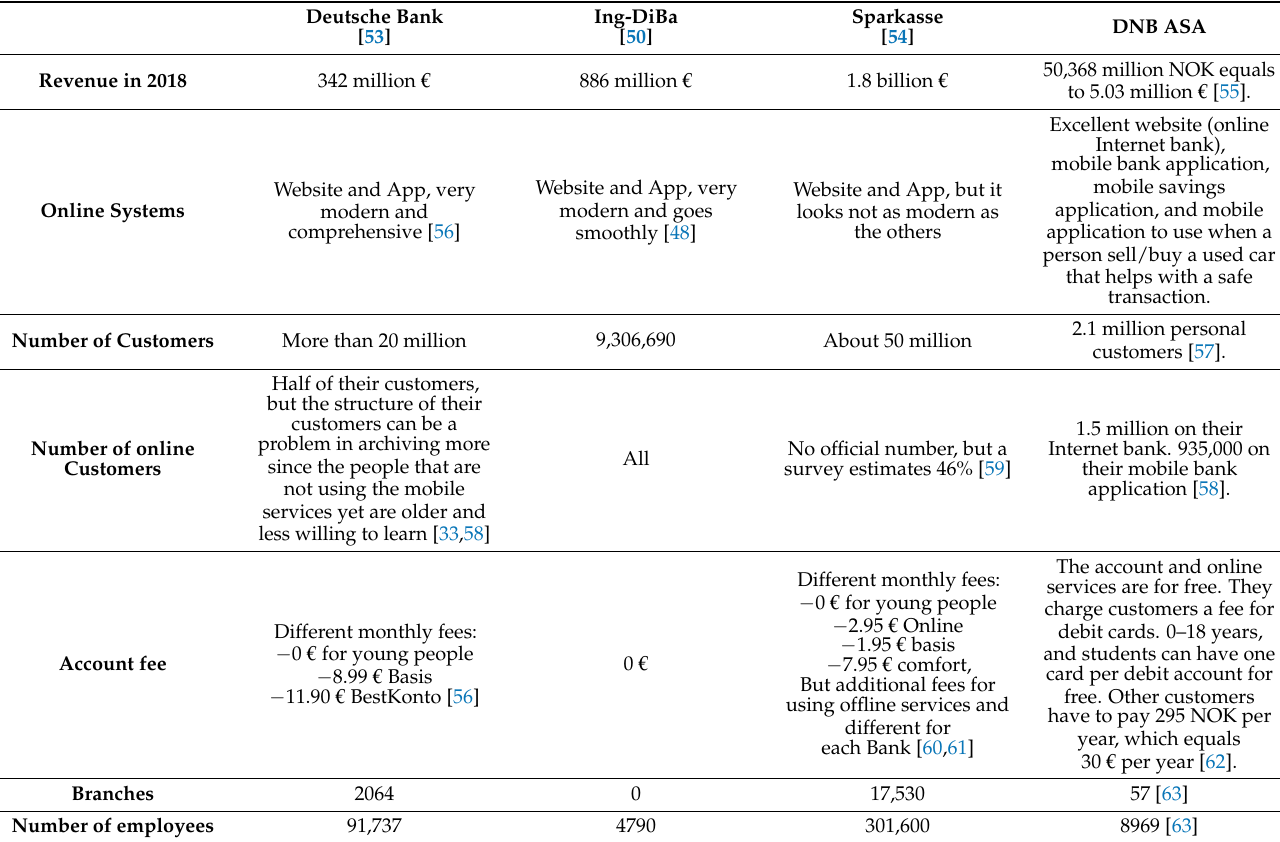
Table 1. Comparison between German banks and